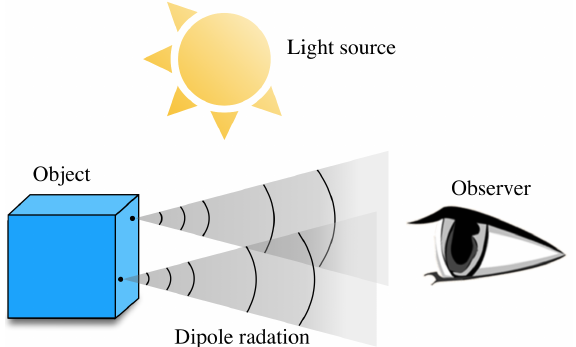
Figure 1. The light source irradiates an object. The surface dipoles start to oscillate and emit mutually incoherent spherical waves as dipole radiation that can be detected by the